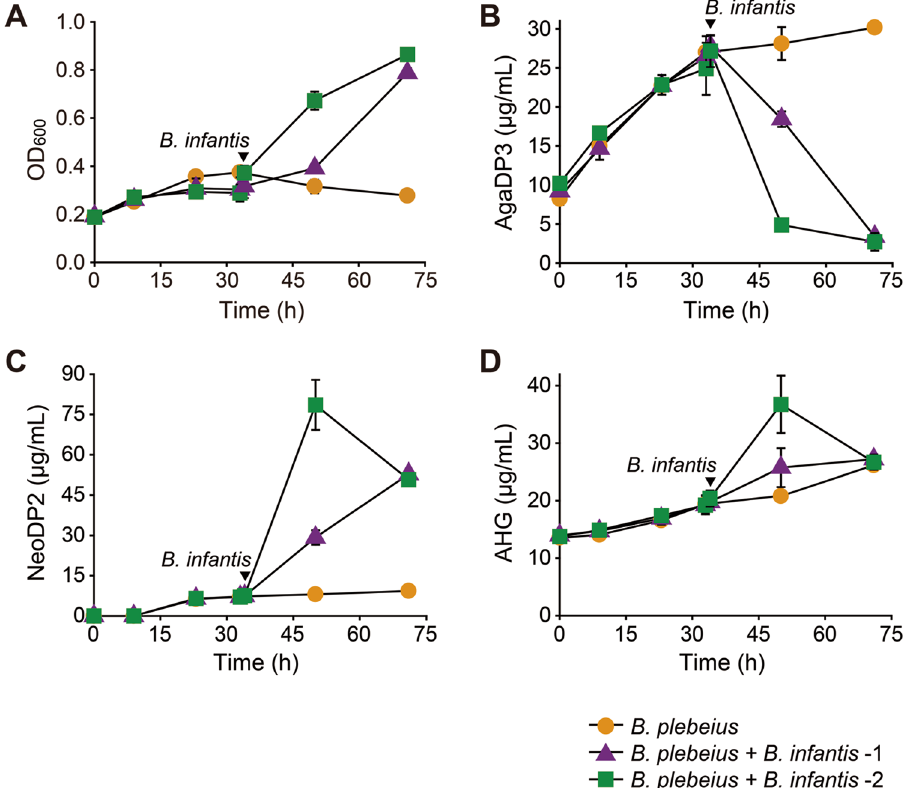
Figure 4. Sequential co-culture of B. plebeius (inoculated initially) and B. infantis (inoculated later at the two different levels of CFUs) for simulating the cooperative actions of the two distinct gut bacteria with regard to agarose degradation. ( A ) Profiles of cell growth represented by cell density measured at 600 nm and fermentation products, AgaDP3 ( B ), NeoDP2 ( C ), and AHG ( D ), during the fermentation of pretreated agarose with B. plebeius only ( B. plebeius in A − D), B. plebeius and B. infantis with a low level of inoculum ( B. plebeius + B. infantis – 1 in A − D), or B. plebeius and B. infantis with a high level of inoculum ( B. plebeius + B. infantis – 2 in A − D). Error bars represent means ±